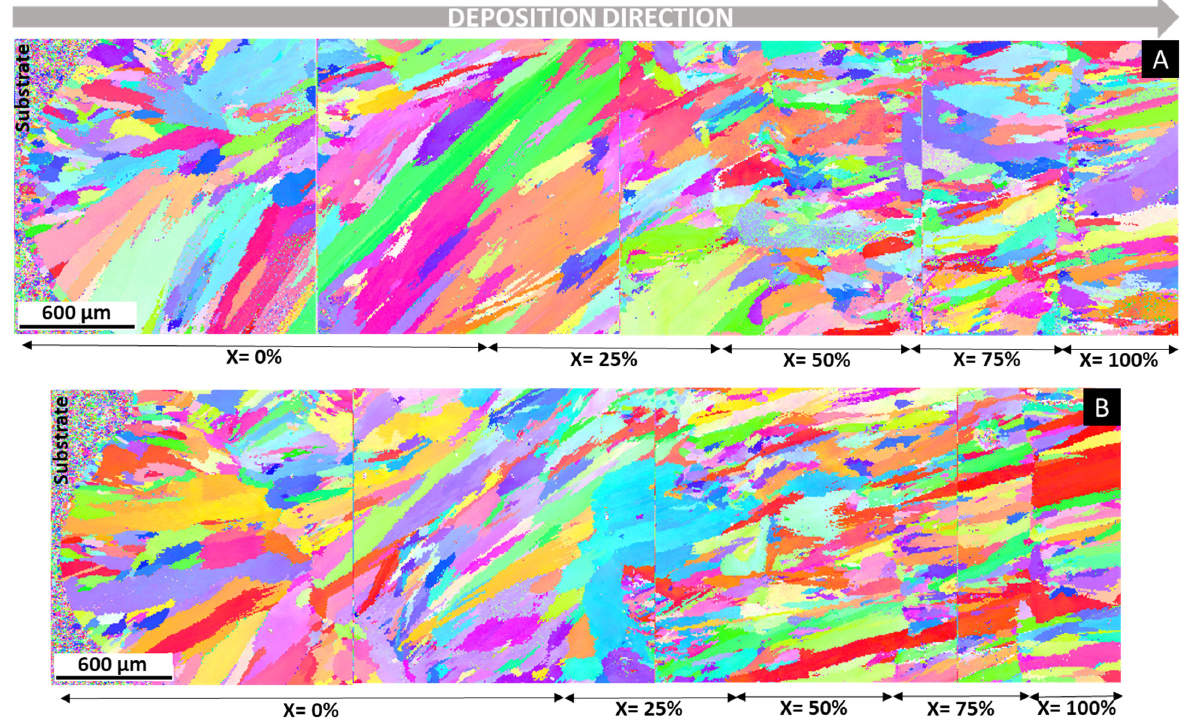
Figure 8. EBSD inverse-pole-figure (IPF) map of the cross-section of FGMs ( A ) without PHT and ( B ) with PHT, showing the morphology and orientation of grains. The composition of each FGM zone is (100-X)% M625 + X% M42C.